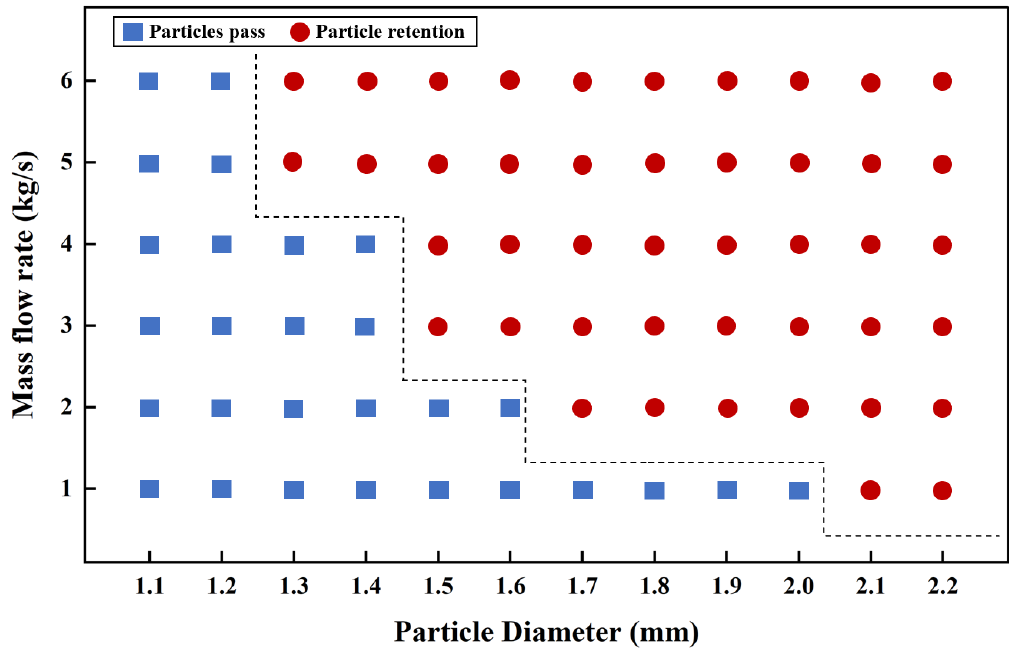
Figure 11. Effect of particle size and mass flow of LCMs on flow properties.